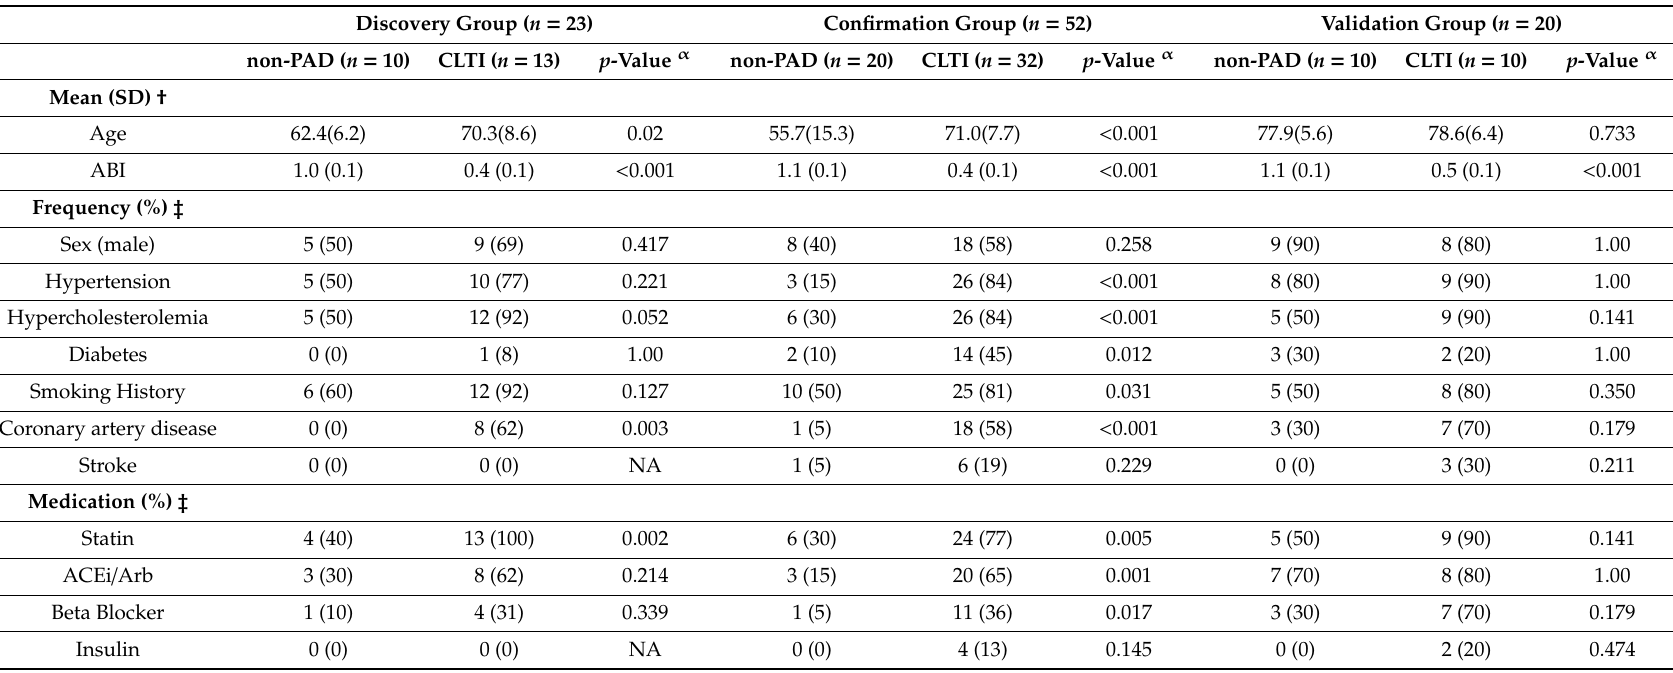
Table 1. General demographics of the study subjects in the discovery, confirmation and validation